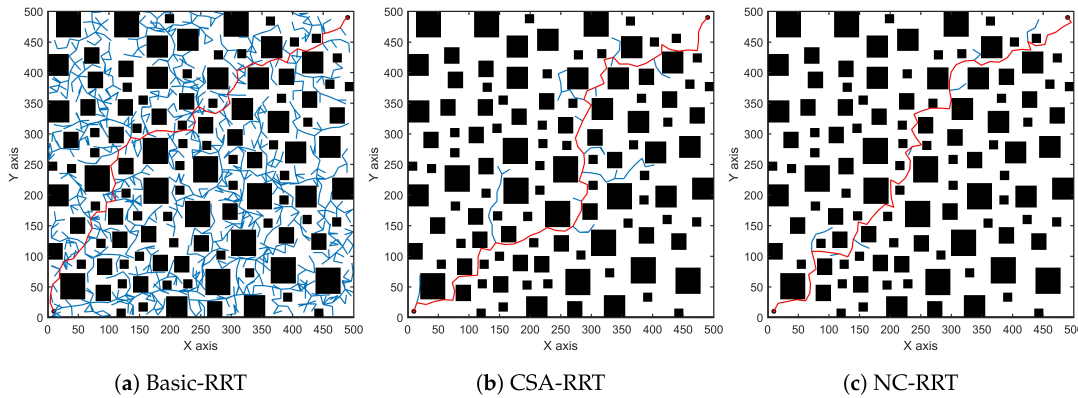
Figure 5. Performance of the three algorithms in the cluttered environment. ( k = 1, c = 2 ) .